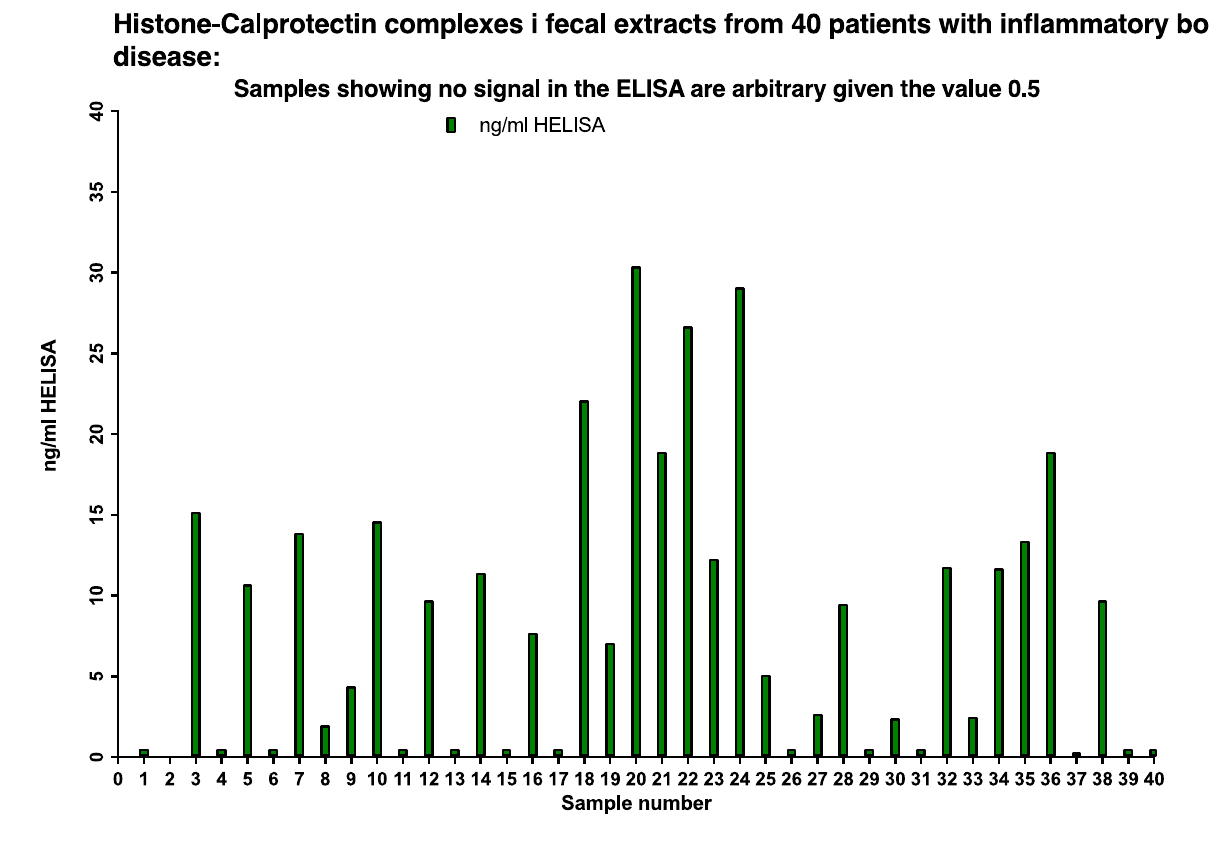
Figure 8. About 65% of IBD patients had between <5 to 30 ng/mL NETs in their stools as evidenced by running a HELISA with anti-histone 3 for capture and anti-calprotectin on top. A poor correlation ( p = 0.31) was found between CP and HELISA values, as shown in Figure 9. Clearly, normal CP may be found even if HELISA levels are high, and vice versa. To look for variation in molecular size, a HELISA positive fecal extract was run on a size exclusion chromatography column, see Figure 10. HELISA reactivity was found in a major peak corresponding to MW from 100 to 200 kDa. In addition, two peaks were eluted at apparent MW larger than 3000 kDa and about 400 kDa, respectively. Finally, four peaks were found in the 10 to two kDa range. The MiMo ELISA showed a peak for CP corresponding to a MW of about 36 kDa. The wide MW distribution of HELISA reactivity may suggest that stool samples contain CP, NETs, and degradation products